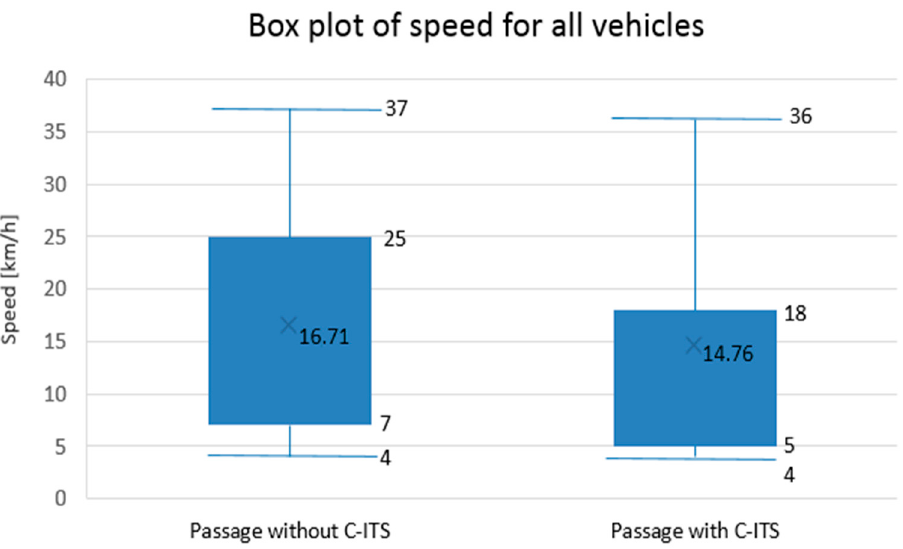
Figure 8. Box plot of speed for all tested vehicles.